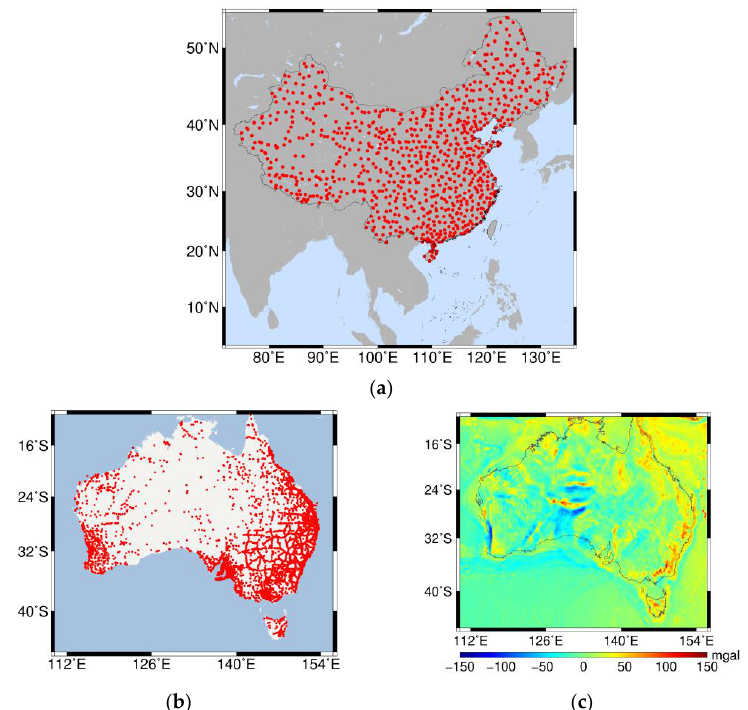
Figure 1. Distribution of the GNSS/leveling data in ( a ) China and ( b ) Australia. ( c ) Distribution of the gridded free-air gravity anomaly in Australia.